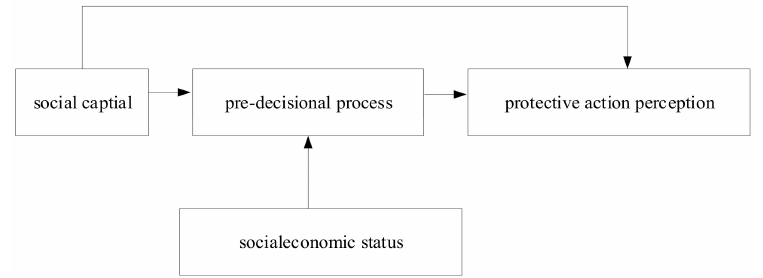
Figure 1. The Influence Model of Social